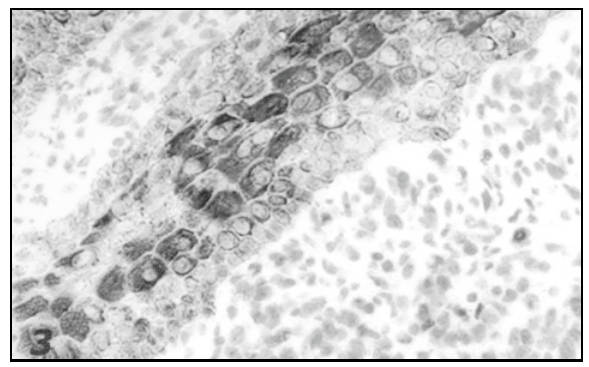
Figure 3 – Skin, anti-cytokeratin AE1/AE3, cytoplasm staining (x 800)